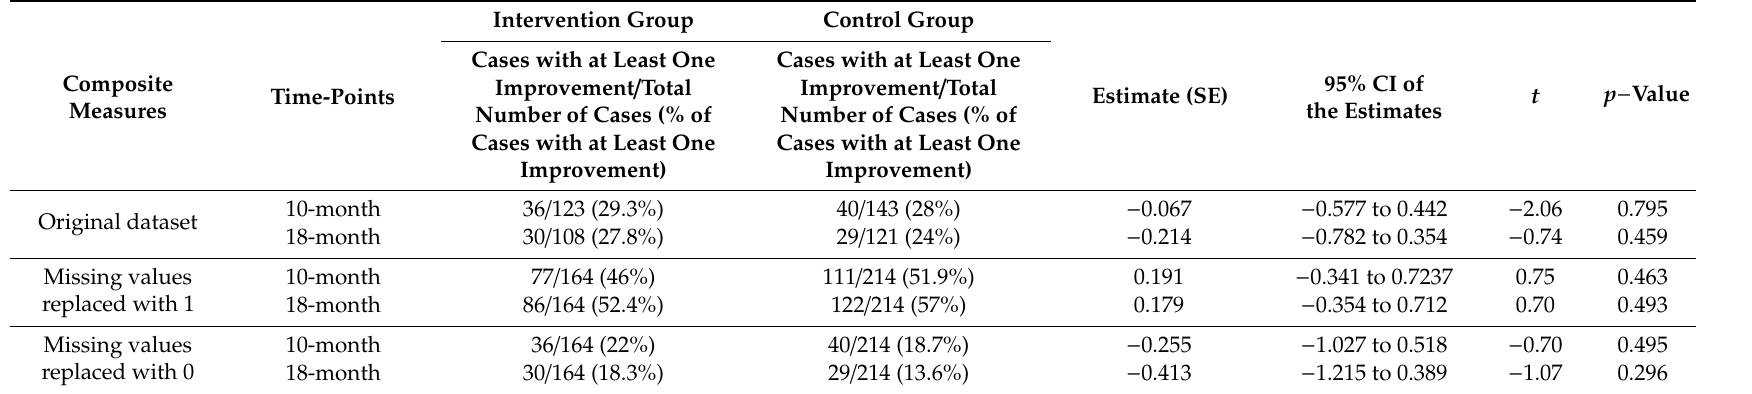
Table 2. Adjusted models for primary outcome with two sensitivity analyses